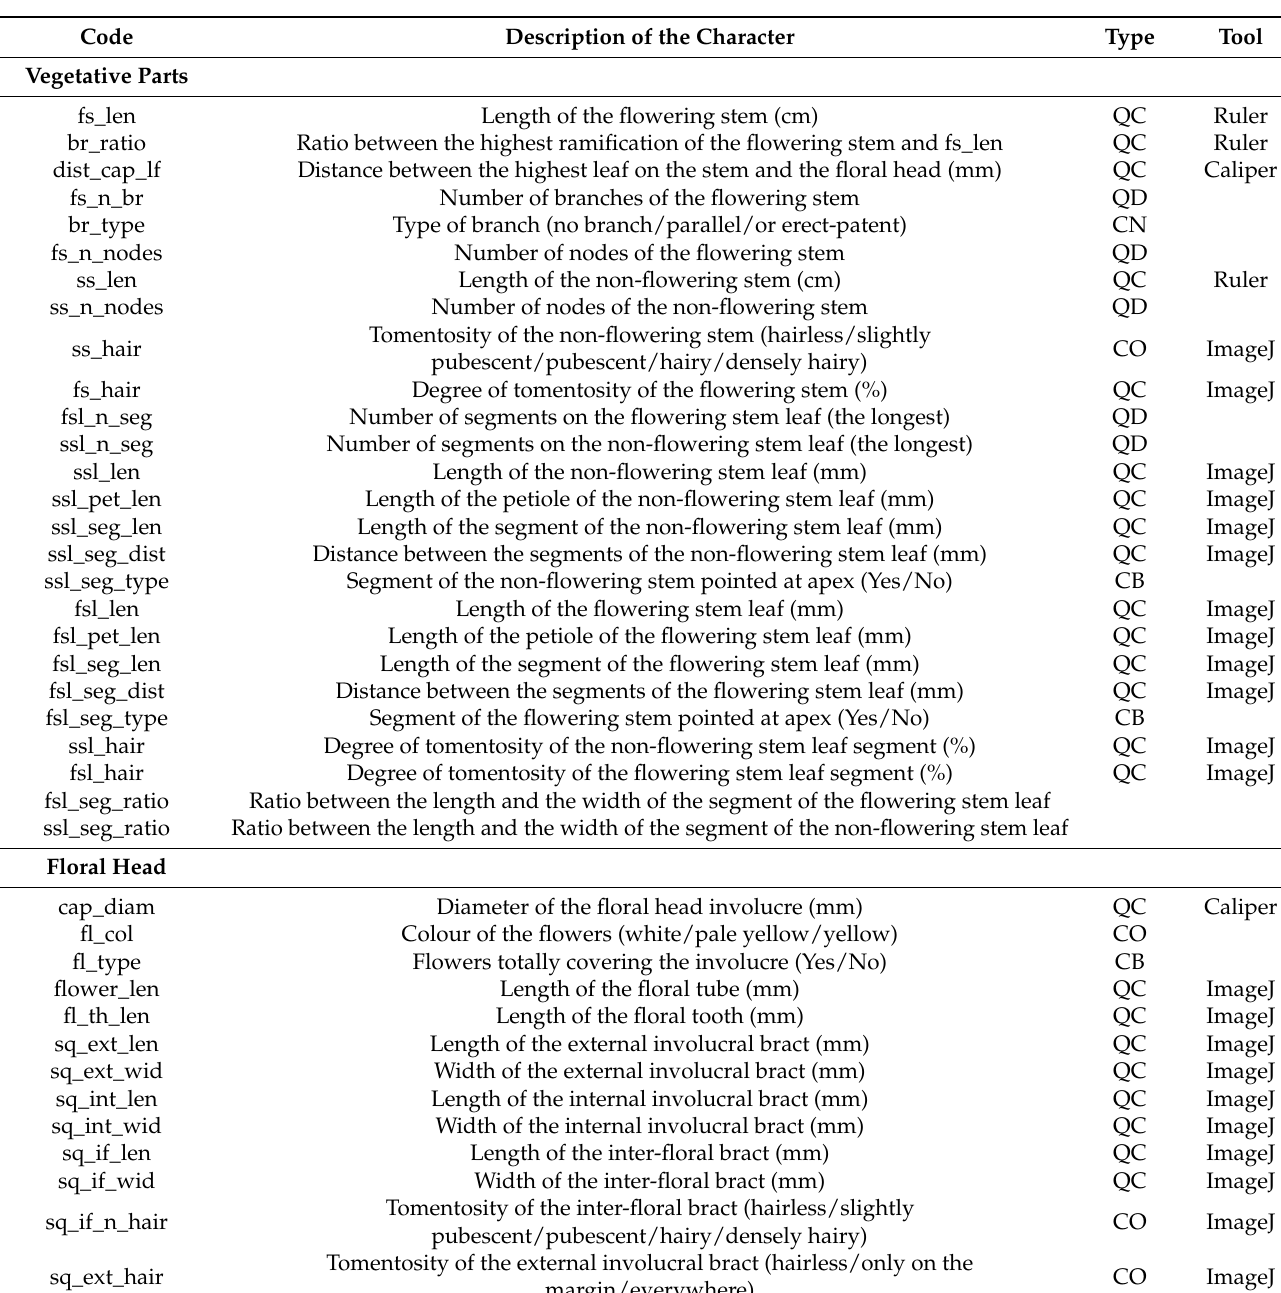
Table 6. The morphometric characters analyzed in the Santolina chamaecyparissus complex. QC = quan- titative continuous, QD = quantitative discrete, CO = ordered factor, CN = nominal, CB =